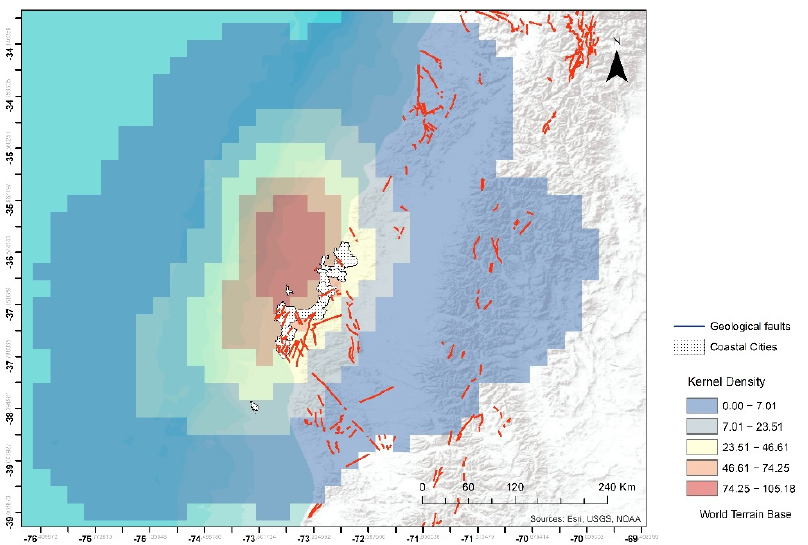
Figure 4. Daily seismic activity density (kernel density) in the study area during the 2006–2017 years. Geological faults are represented by red lines.